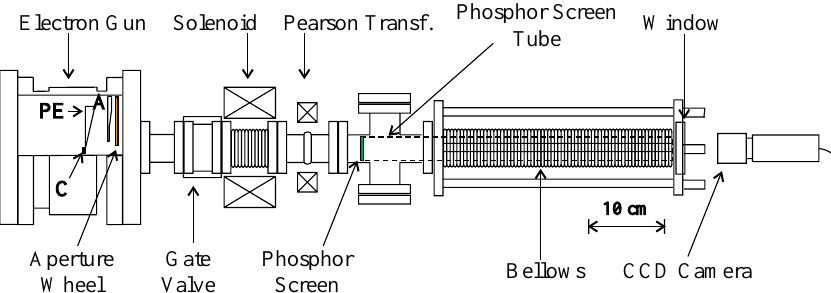
FIG. 1. Solenoid experiment setup. The cutout on the electron gun shows the cathode (C), Pierce focusing electrode (PE), and anode (A). The gridded electron gun has a mesh (not shown) in front of the cathode. In the setup for the convergent-type gun, a gasket with a 1 (cid:1) 4 -in. (diam) hole is used to collimate the beam at the downstream side of the gate valve.